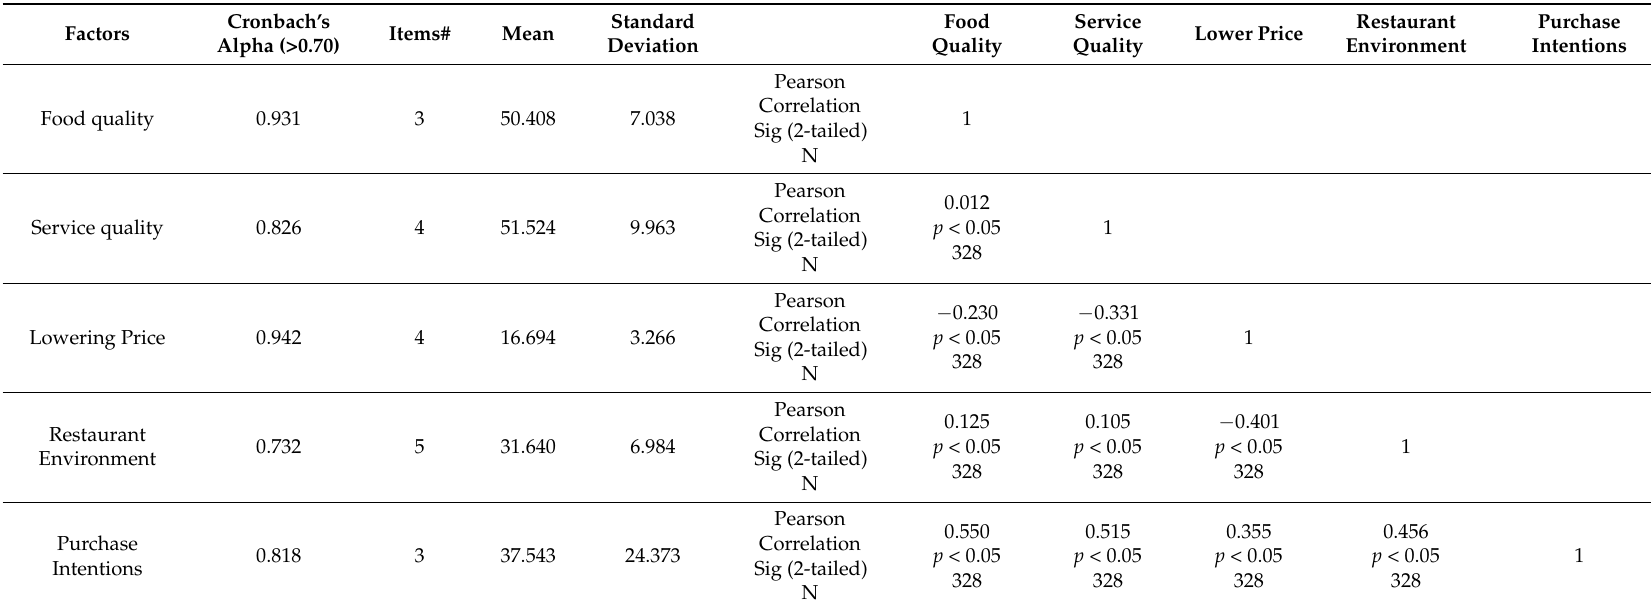
Table 3. Reliability Testing, Mean, Standard Deviation, and Correlation on Independent